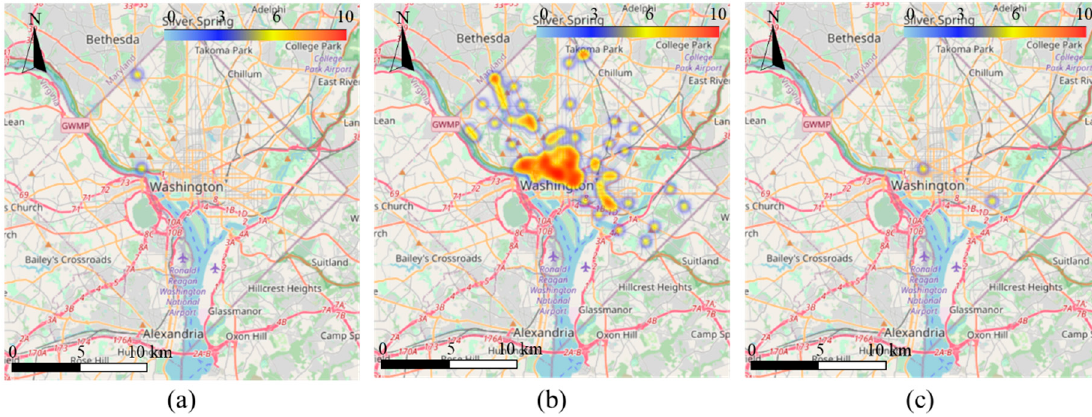
Figure 11. Hotspots of burglary in Washington D.C. ( a ) 24 May 2020; ( b ) 31 May 2020; ( c ) 7 June 2020.